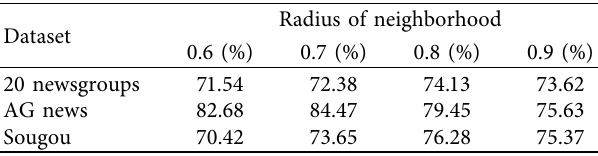
Figure 4: Experimental results of historical days based on Weibo-late-numerical. Table 2: Experimental results of domain radius selection under various